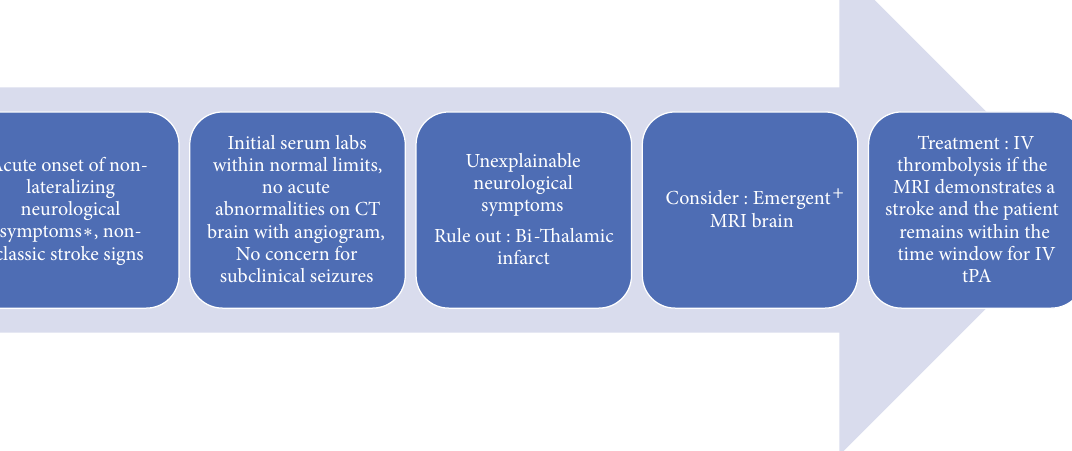
Figure 3: Proposed comprehensive radiological evaluation pathway to be completed in the Emergency Department. ∗ Acute onset of any of the following symptoms: altered mental status, memory impairment, hypersomnolence, coma, aphasia, and vertical gaze palsy. + Emergent MRI brain without contrast with limited series of images to be done only if the patient is within the therapeutic window for thrombolysis ( < 4.5hrs since symptom